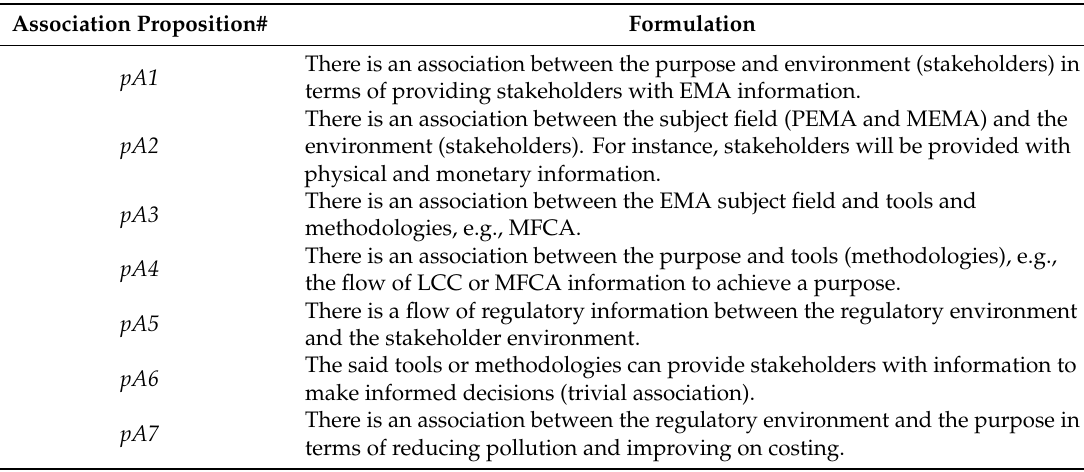
Table 3 denotes the association propositions that emerged from the interplay among the entities identified. Table 3. List of association propositions.